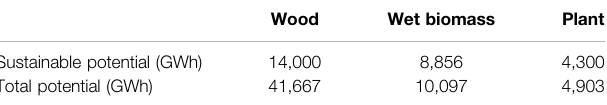
TABLE 2 | Domestic biomass potential for Switzerland, extracted from Burg et al. (2018). Wood Wet biomass